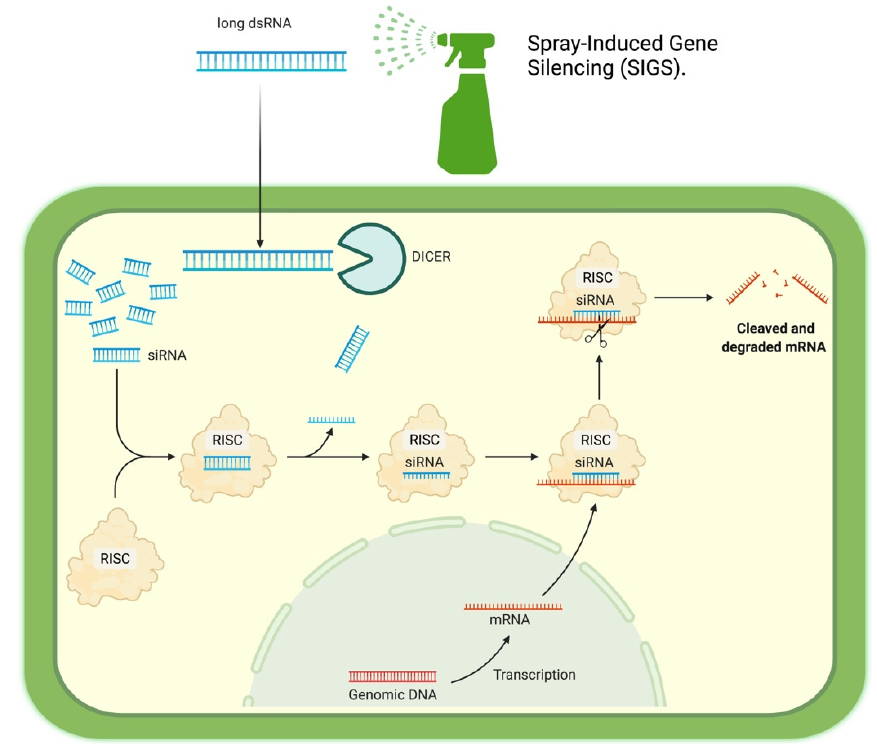
Figure 1. Spray-induced gene silencing (SIGS) mechanism.